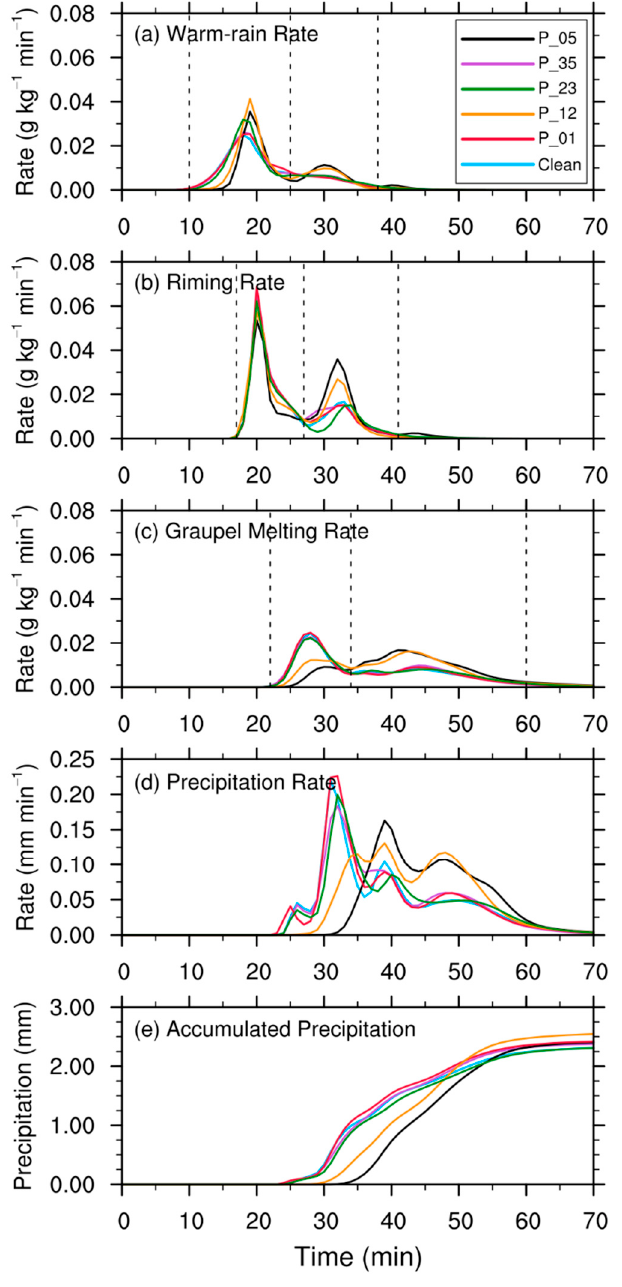
Figure 5. The time series of column-averaged ( a ) warm-rain rate, ( b ) riming rate, and ( c ) graupel melting rate, and area-averaged ( d ) precipitation rates, ( e ) accumulated precipitation of all the simu- lations. The dashed lines in ( a – c ) are the dividing lines for the rate peaks of the three microphysical processes. The column-averaged region is the same as the column in Figure 4, and the area-averaged region is the same as the base of the